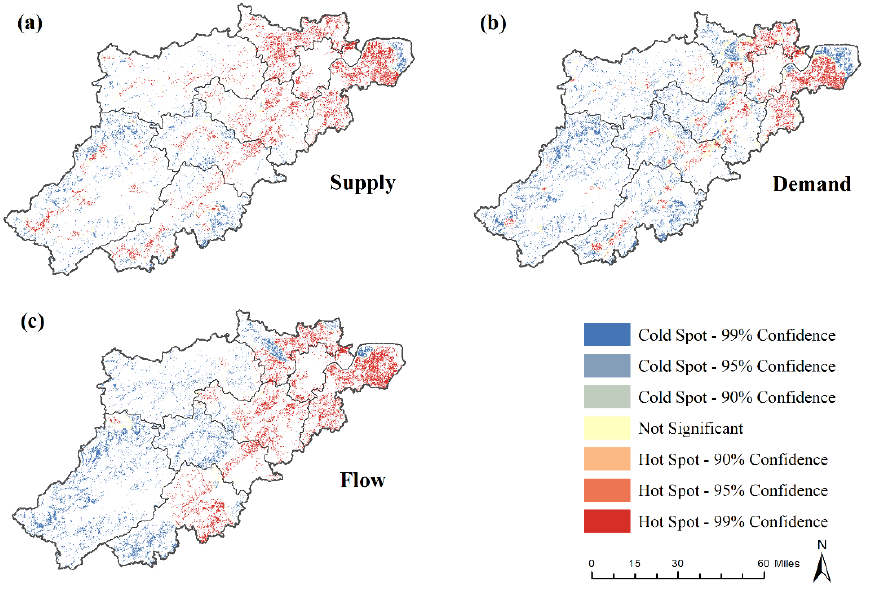
Figure 3. Patterns of hot and cold spots of ( a ) supply, ( b ) demand, and ( c ) flow maps. Table 3. Distribution of agricultural CES values for different agricultural land use types. Types of